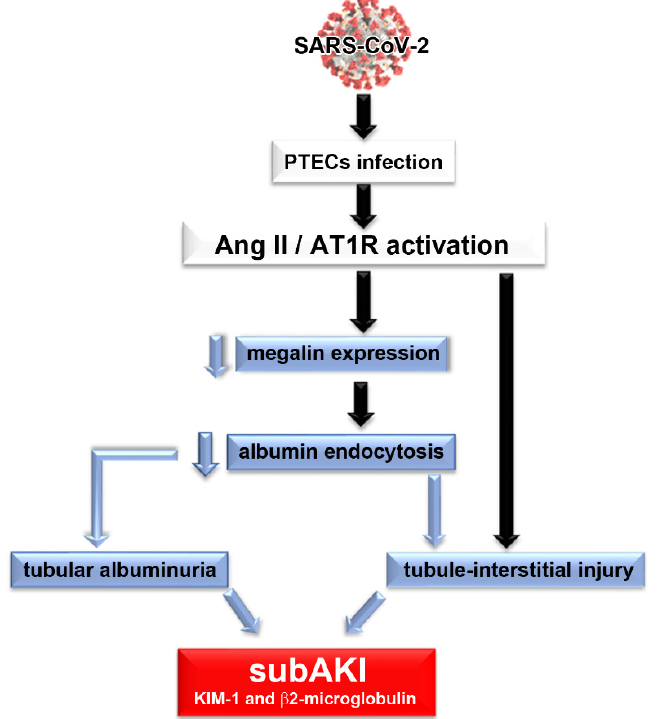
Figure 1. Proposed model of the genesis of subclinical acute kidney injury in patients with COVID-19. We proposed that PTEC SARS-CoV-2 infection promotes overactivation of the Ang II/AT1R axis, which leads to a decrease in megalin expression, a decrease in albumin endocytosis and consequently, tubular albuminuria. Development of tubule interstitial injury could be caused by changes in the albumin endocytosis machinery per se and/or due to a direct effect of overactivation of the Ang II/AT1R axis. All these conditions characterize the development of subAKI. In this case, tubular injury biomarkers, such as KIM-1 and β 2-microglobulin, and albuminuria could be observed in the urine of patients.